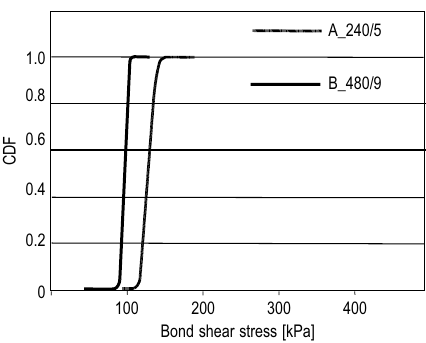
Fig. 6. Chart of CDF’s of Lognormal distribution of random variable